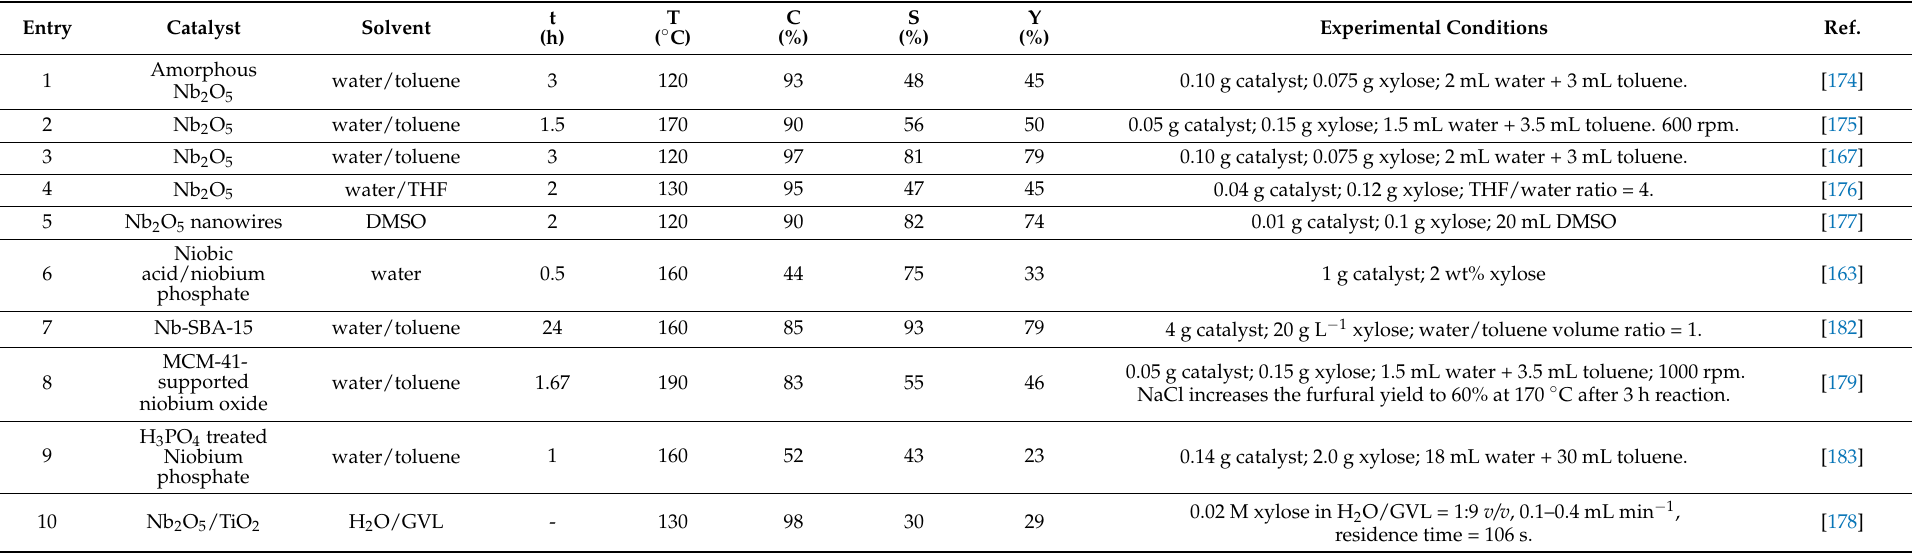
Table 6. Performance of niobium-based catalysts for conversion of xylose into furfural—from 2010 to date.